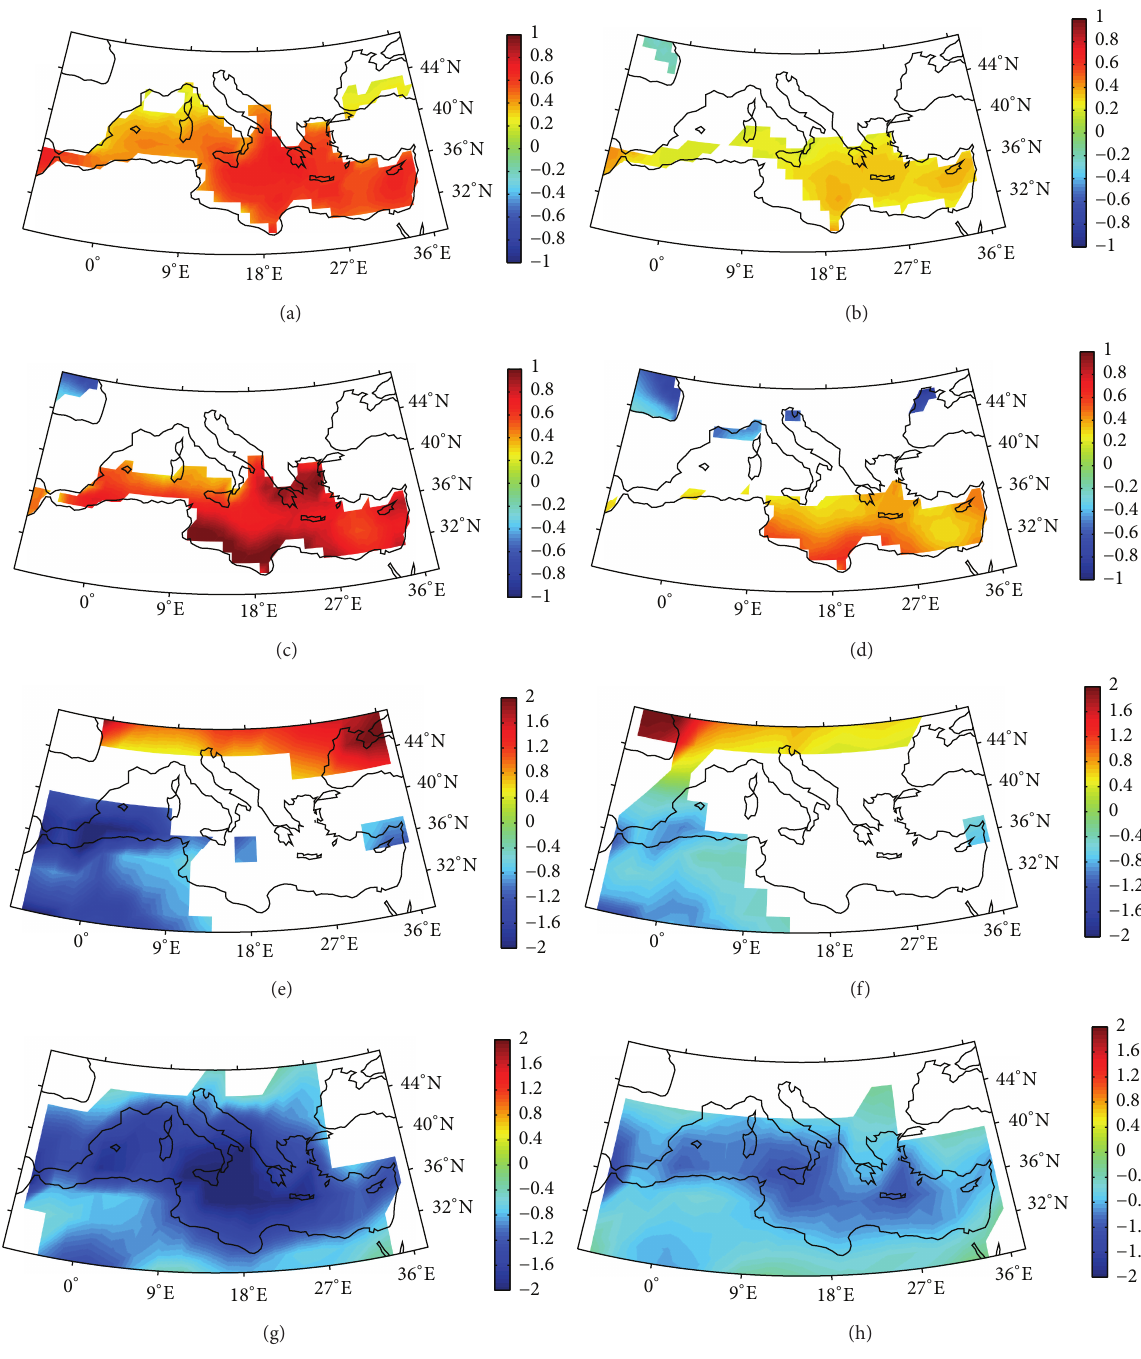
Figure6:(a),(c),(e),and(g)AHhigh/eastcomposite-AHlow/westcompositeofmonthlymean 𝑄 𝑎 - 𝑄 𝑠 (g/kg), 𝑇 𝑎 - 𝑇 𝑠 (C), 𝑢 (m/s),and V (m/s); (b), (d), (f), and (h) NAO+ composites-NAO − composite of monthly mean 𝑄 𝑎 - 𝑄 𝑠 (g/kg), 𝑇 𝑎 - 𝑇 𝑠 (C), 𝑢 (m/s), and V (m/s), DJF 1958–2011. Only differences which are significant at 𝑃 = 0.05 are